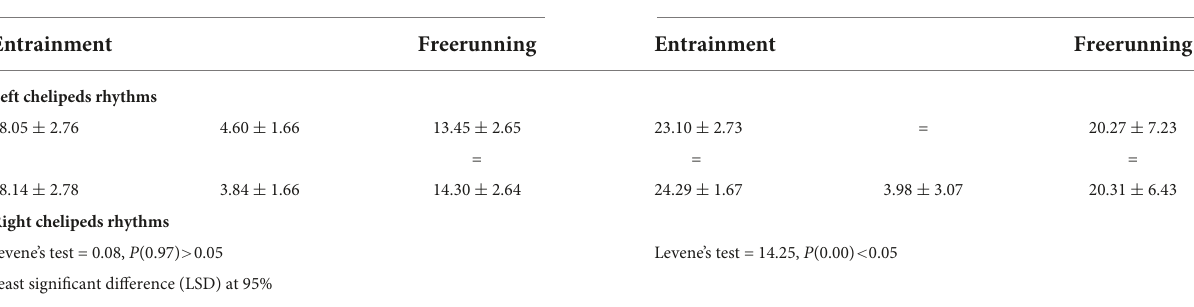
TABLE 3 Results of the comparisons of the means of the four batches, with 21 data each, of the average periods and the modal periods (first row), under entrainment and freerunning (second row) of the two cheliped (fourth row for the rhythms of the left cheliped and sixth row for the rhythms of the right